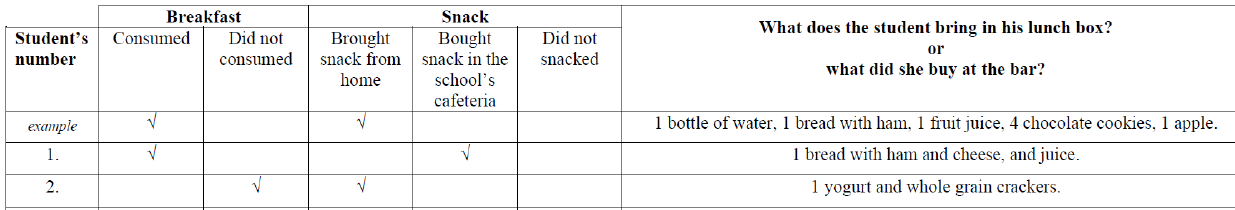
Figure 2. Example of a part of an observational grid.